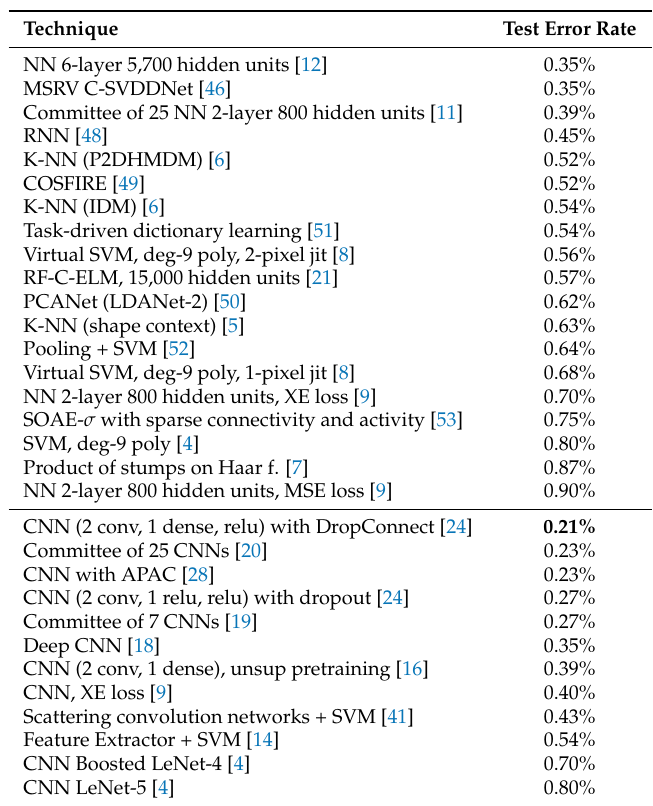
Table 1. Side-by-side comparison of the most competitive (error rate < 1%) results found in the state of the art for the MNIST database with data augmentation or preprocessing. Best achieved performances are boldfaced.